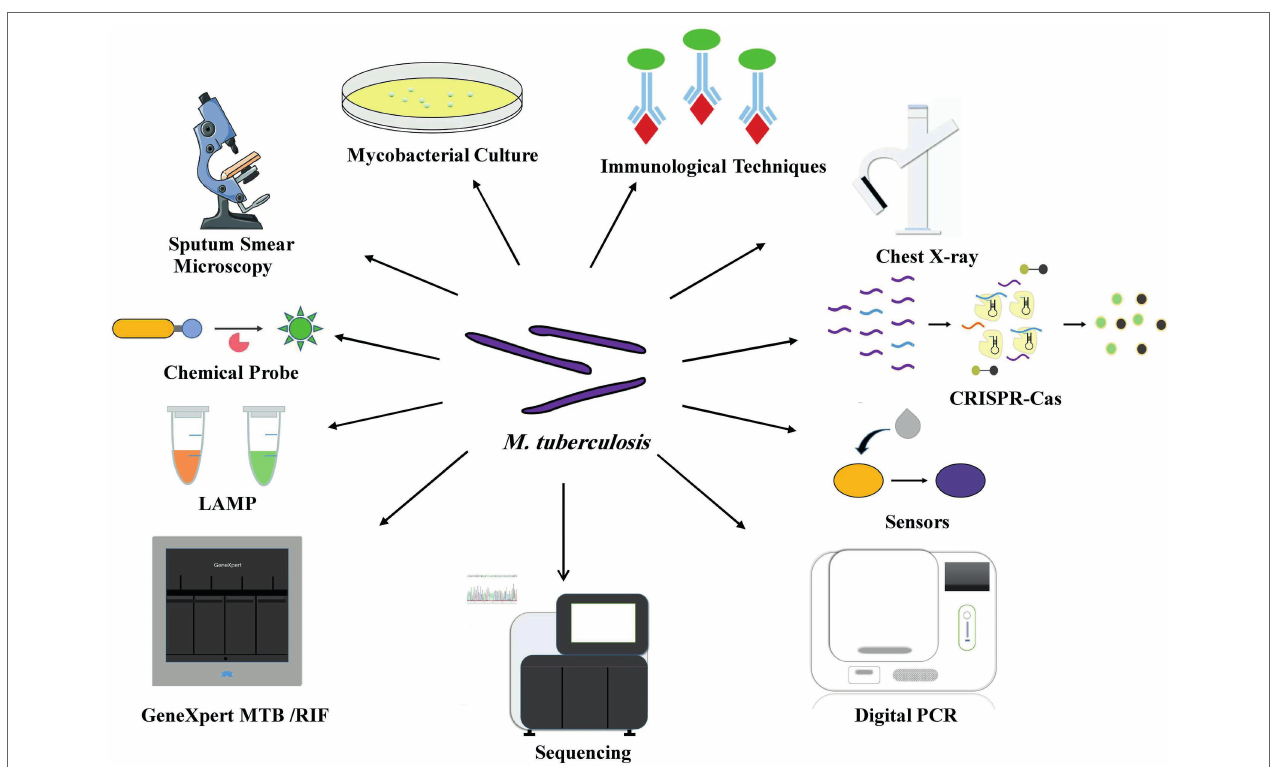
FIGURE 1 | Various diagnostic tools for TB point-of-care